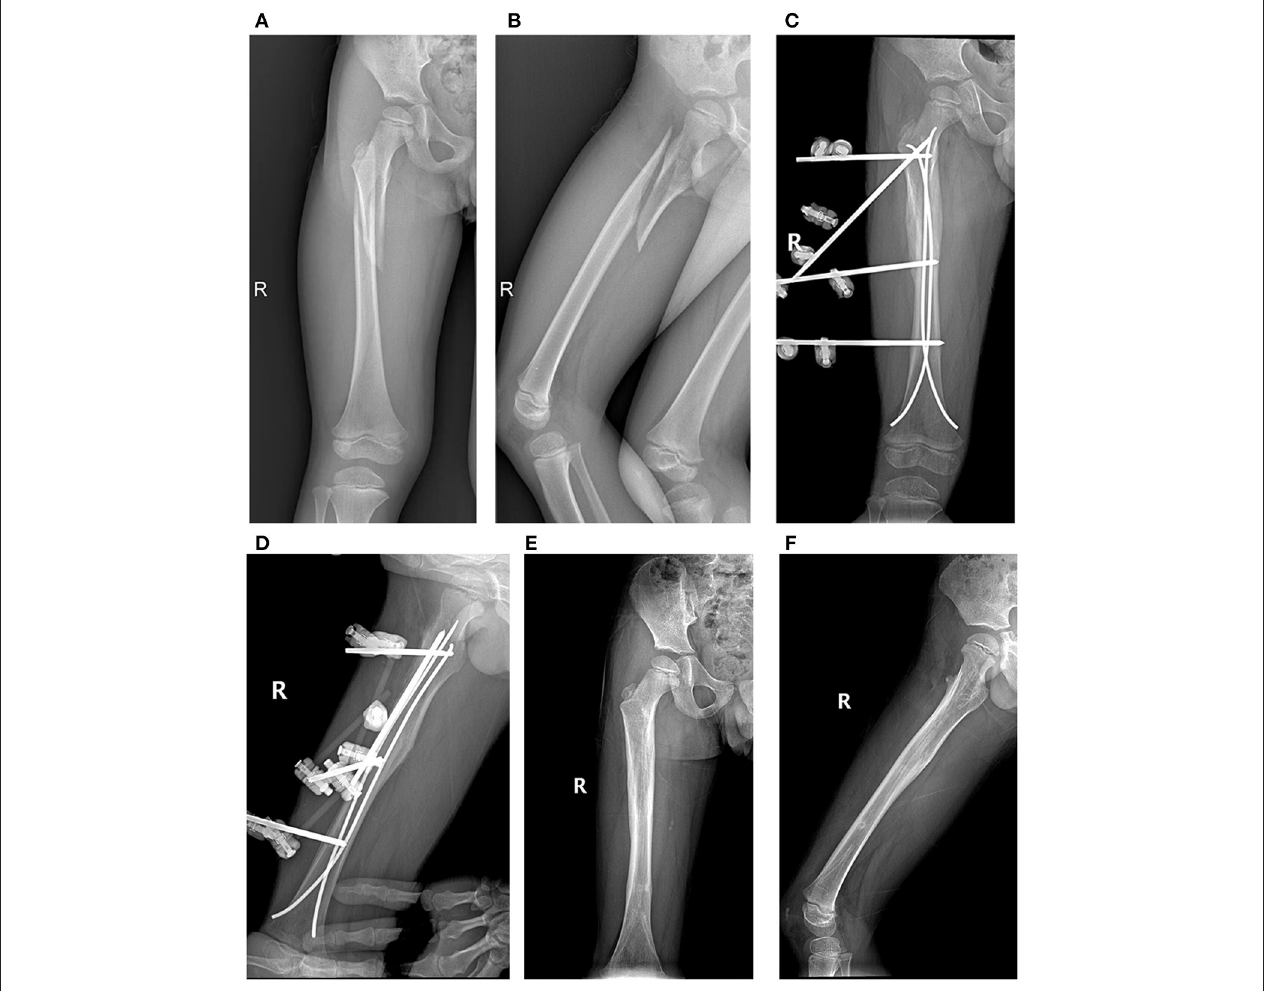
FIGURE 4 | Case 18. (A,B) Long oblique proximal fracture of a 7-year-old boy; (C,D) postoperative radiographs; (E,F) final outcome.